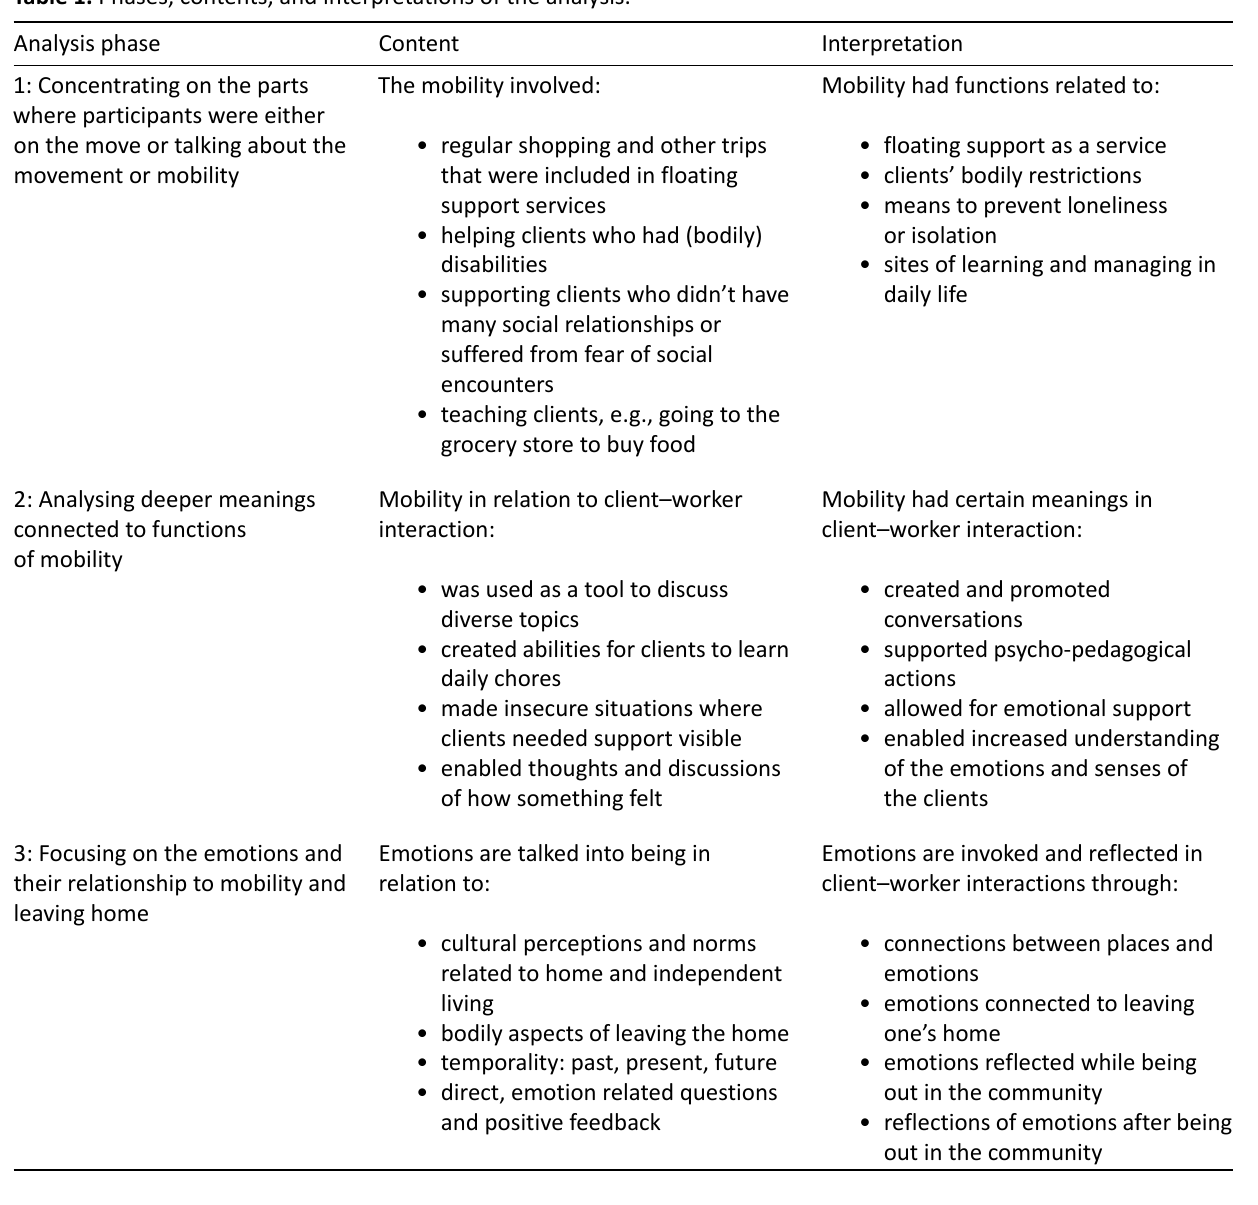
Table 1. Phases, contents, and interpretations of the